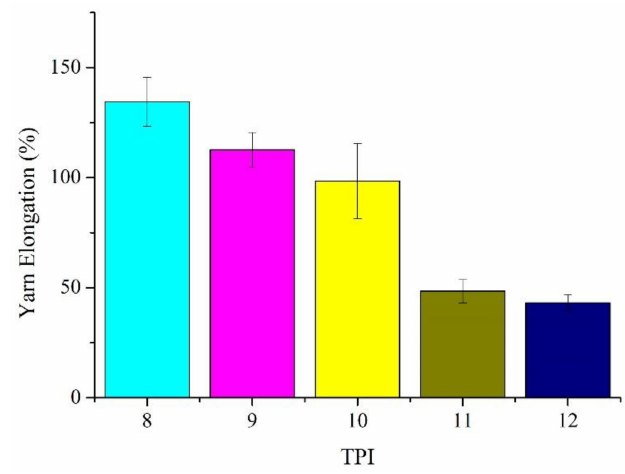
Figure 5. Tensile elongation of the Ge/SS core-spun yarns.